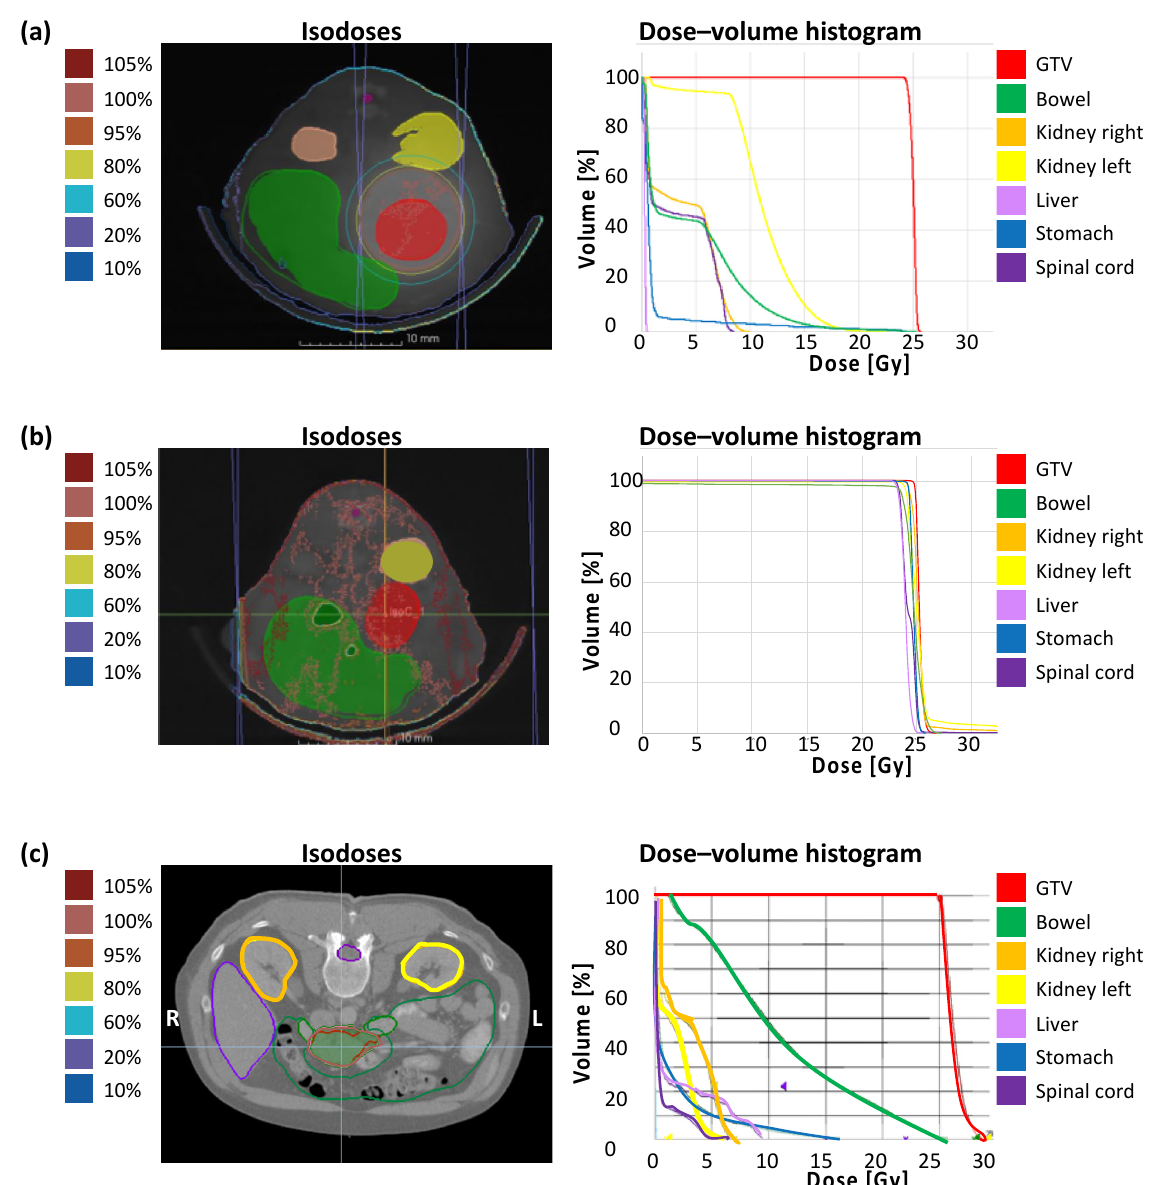
Figure 3. Treatment planning containing dose distribution with isodoses and dose–volume histogram. ( a ) Single-dose SBRT with 25 Gy in arc technique with a gantry rotation between 178° and − 178° in vivo; ( b ) Wholeabdomen RT with 25 Gy in AP/PA technique in vivo; ( c ) Clinical example of a single-dose SBRT with 25 Gy in a PDAC patient.